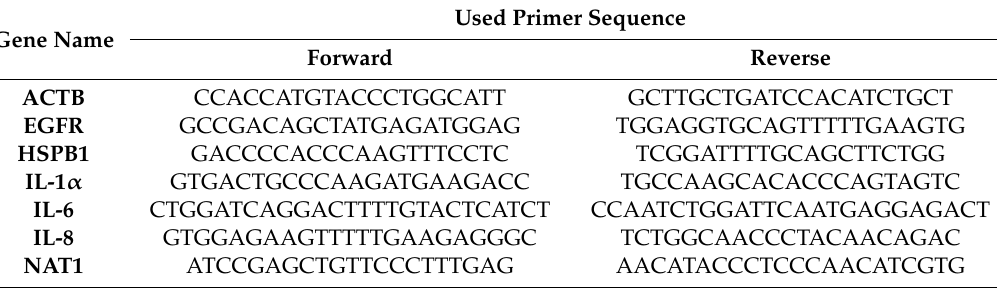
Table 1. Primer sequences for PCR studies.